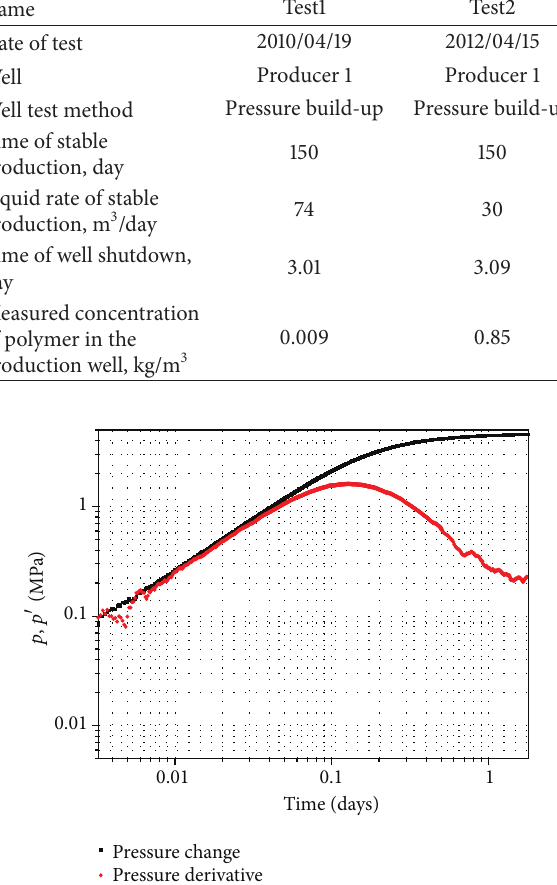
Figure 10: Measured pressure change and pressured derivative curves for